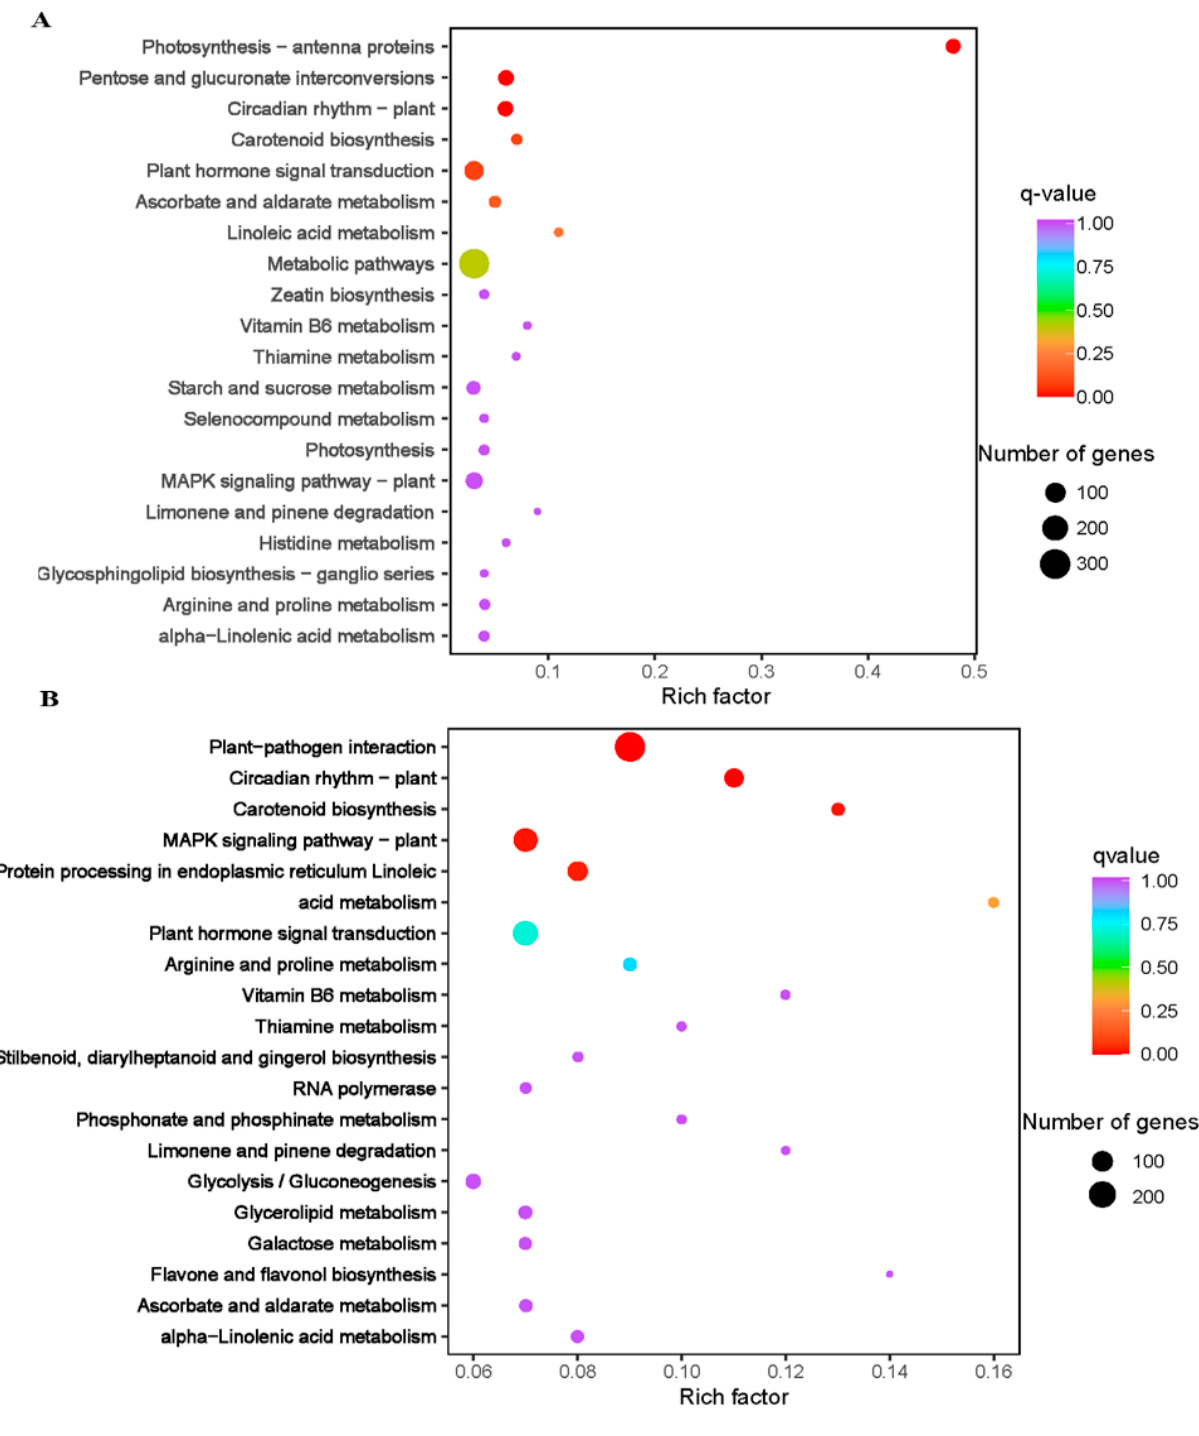
Figure 3. Kyoto encyclopedia of genes and genomes’ pathway enrichment scatter bar plots of differentially expressed genes in the two contrasting genotypes of rapeseed (XY15 (sensitive) and GX74 (tolerant)) under before (CK) and after cold treatment (LW). ( A ). XY15CK vs. XY15LW. ( B ). GX74CK vs. GX74LW.